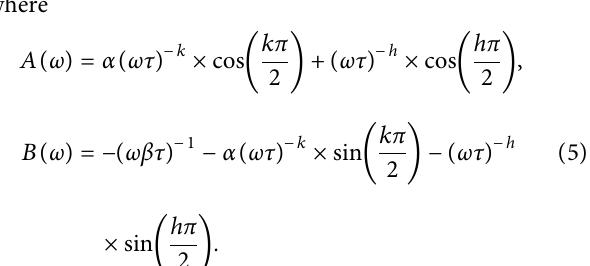
Figure 1: 2S2P1D model.